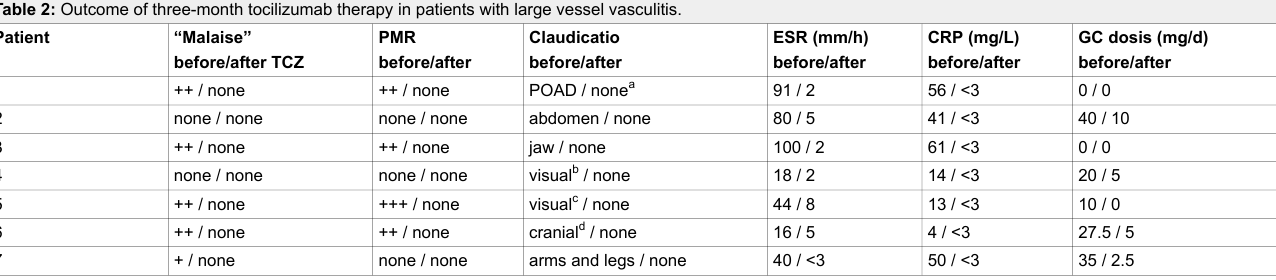
art. HT = arterial hypertension Table 2: Outcome of three-month tocilizumab therapy in patients with large vessel vasculitis.